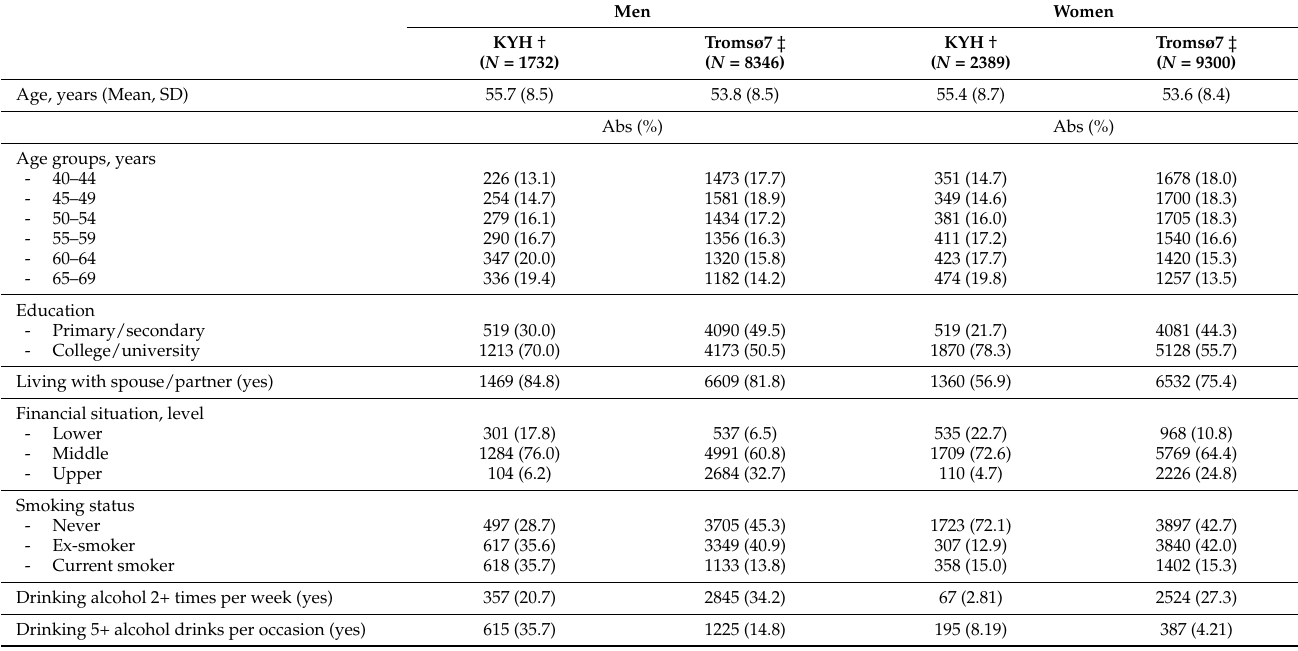
Table 1. Socio-demographic characteristics and health behaviors of studied populations by study and